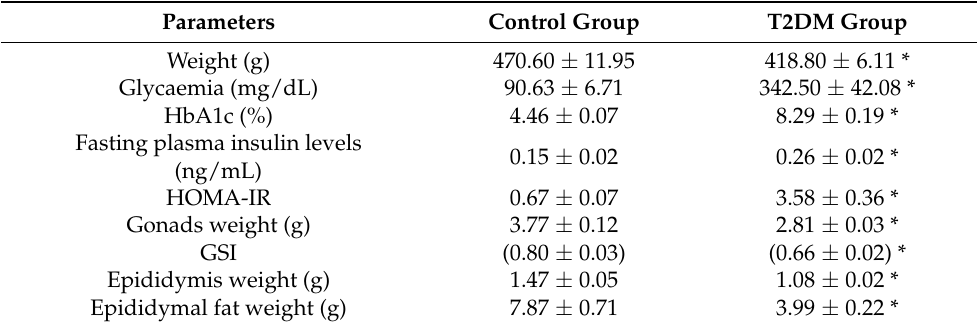
Table 1. Effect of T2DM on average weight, glycemia, HbA1c, insulin, and reproductive organs’ weight from the control group and T2DM